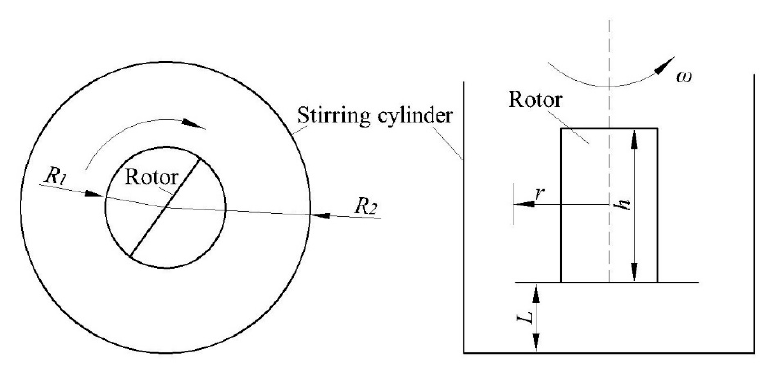
Figure 2. Schematic diagram for the rotor rotation.